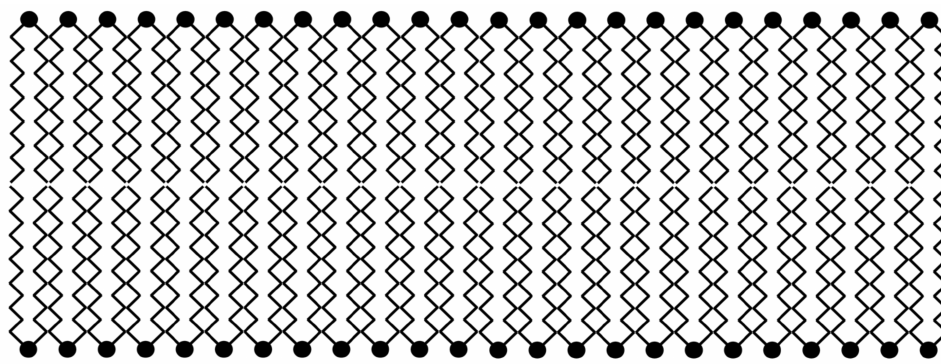
Scheme 1. Schematic presentation of synthetic lipid-like compound